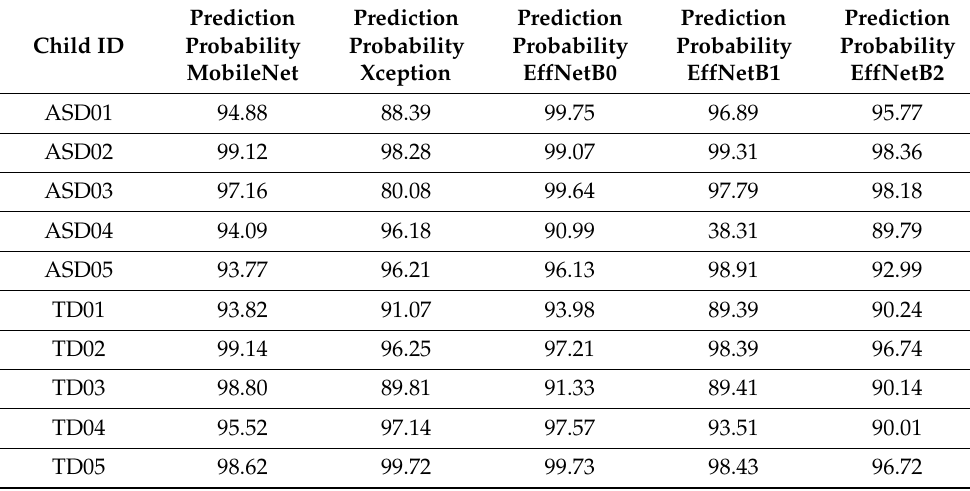
Figure 12. Comparison of model performance based on sensitivity, specificity, NPV, PPV and AUC. The models yielded a prediction rate for each case, which indicates the probability that each child will be classified as autistic or not. On the 300 test data samples, Table 3 shows the prediction rates of the five models (only five records from each class are included in Table 3). We devised a new scoring method for autistic and TD children based on class probabilities with a threshold of 95%. According to the scoring methods, if a model’s prediction meets the threshold, it receives one point. A comparison of model performance based on the new scoring is shown in Figure 13. The EfficientNetB0 showcased consistent scores of 59.33% for autistic class and 58.67% for TD class. Table 3. Prediction scores of the five models (first five records from each